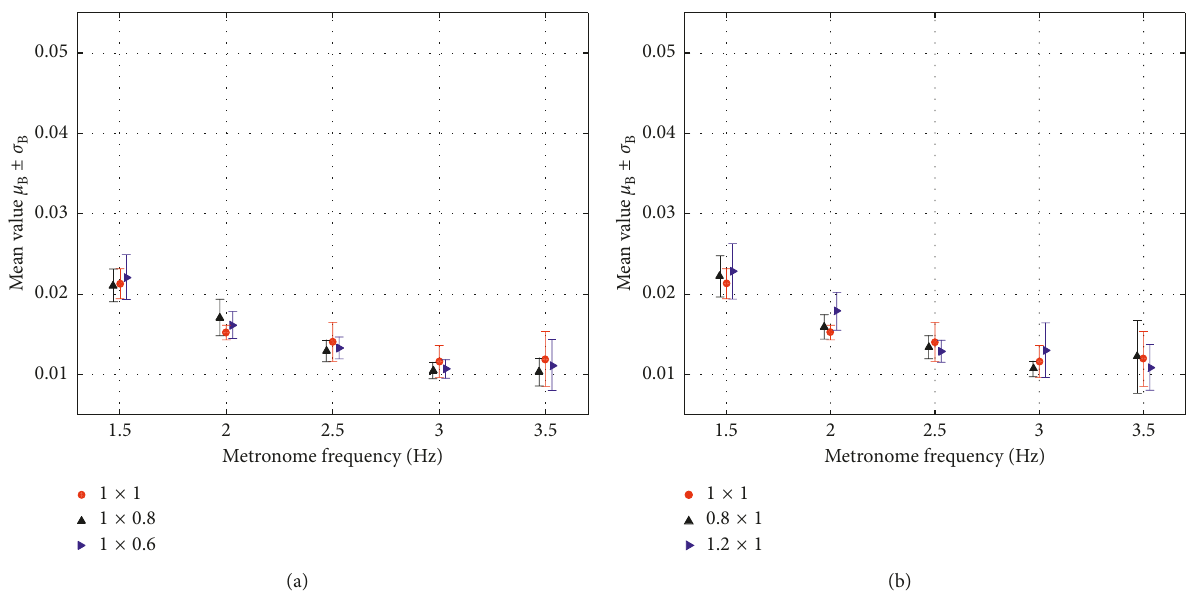
Figure 27: Comparison of equivalent bandwidth with three configurations in two groups. (a) Group 01 with different lateral distances; (b) group 02 with different frontal